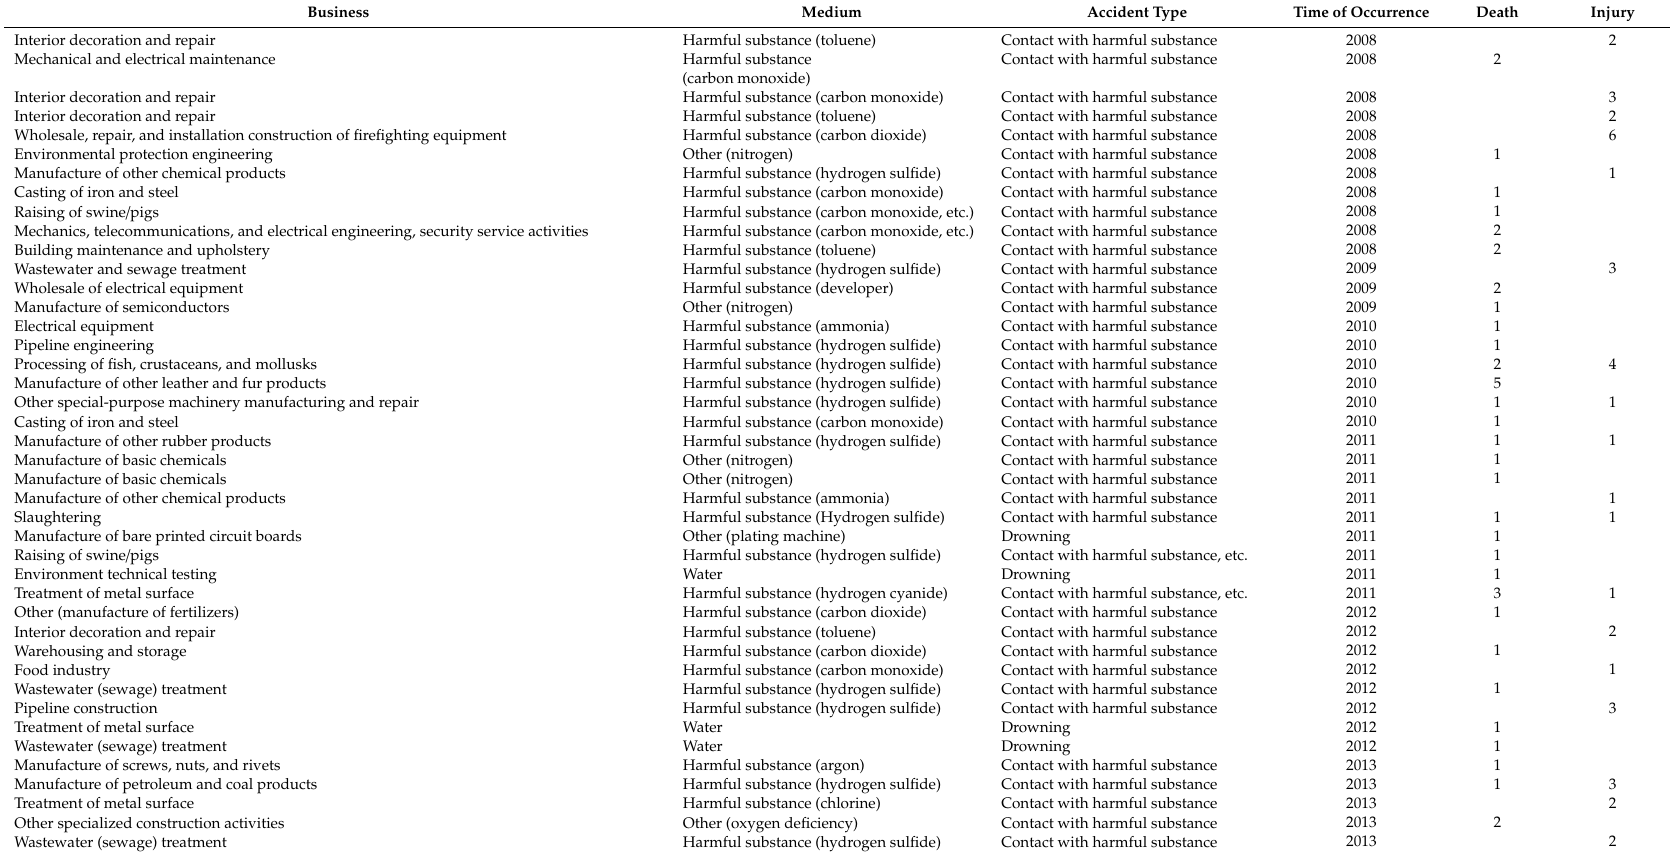
Table 1. Statistics for catastrophic and fatal occupational accidents associated with confined spaces in Taiwan from 2008 to